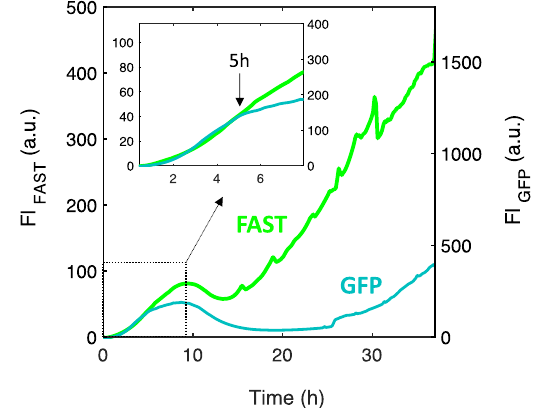
Fig. 4 Bt -FAST and Bt -GFP signals diverge at the characteristic time t 1 . Kinetics of the fl uorescence intensity, Fl, from Bt -FAST and Bt -GFP grown in parallel channels in the 4S bio fi lm. The curves represent the average of at least three independent measurements. The arrow indicates time t = 5 h, when the GFP and FAST signals diverged. The insert shows a zoom in on the fi rst 8 h of bio fi lm formation. The same experimental conditions were used as in Fig. pro fi le, which is also clearly distinct from that of Bt and Pf . The synchronized Bt and Pf spatial transition reinforces the hypothesis of the coupling of these two populations in the community on the bottom surface. In addition, the temporal correspondence of this spatial transition with the second growth phase indicates that this apparent translocation corresponds to a geographically restricted